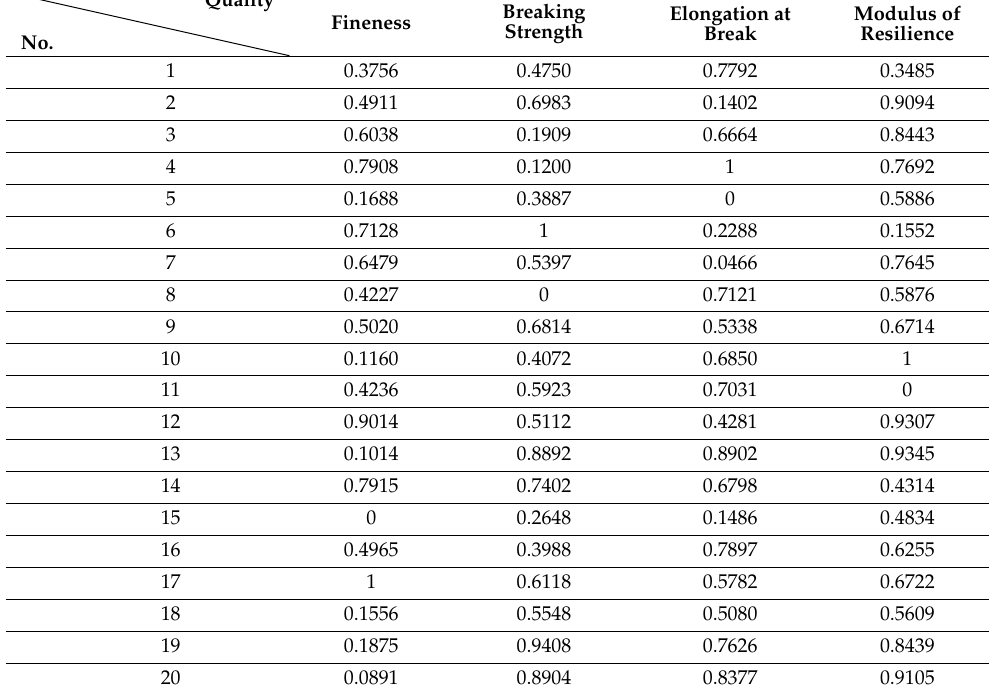
Table 5. The outputs of the neural network.